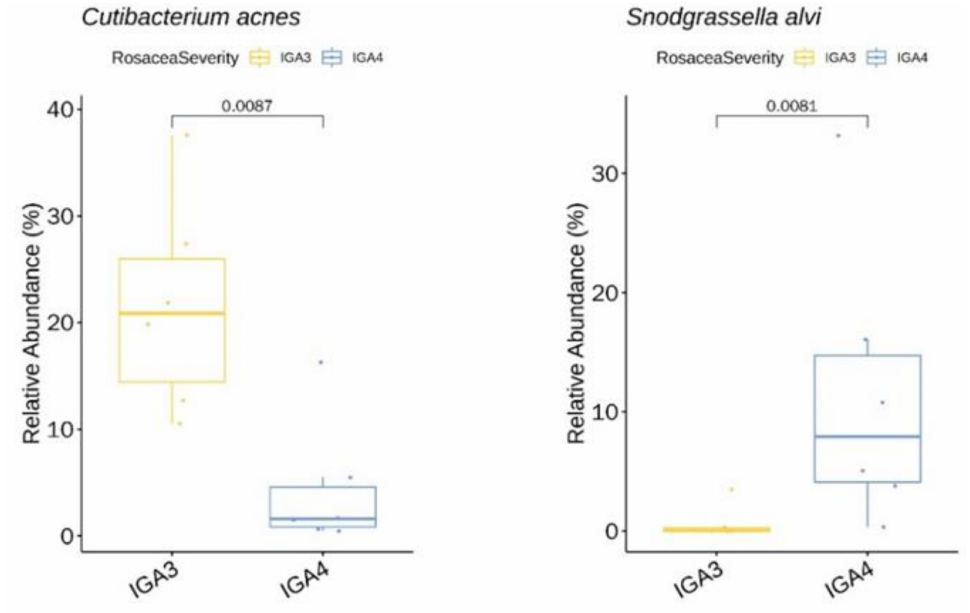
Figure 7. C. acnes showing a significantly lower relative abundance in the IGA 4 rosacea severity group at baseline. Snodgrassella alvi with a higher relative abundance in the IGA 4 group at